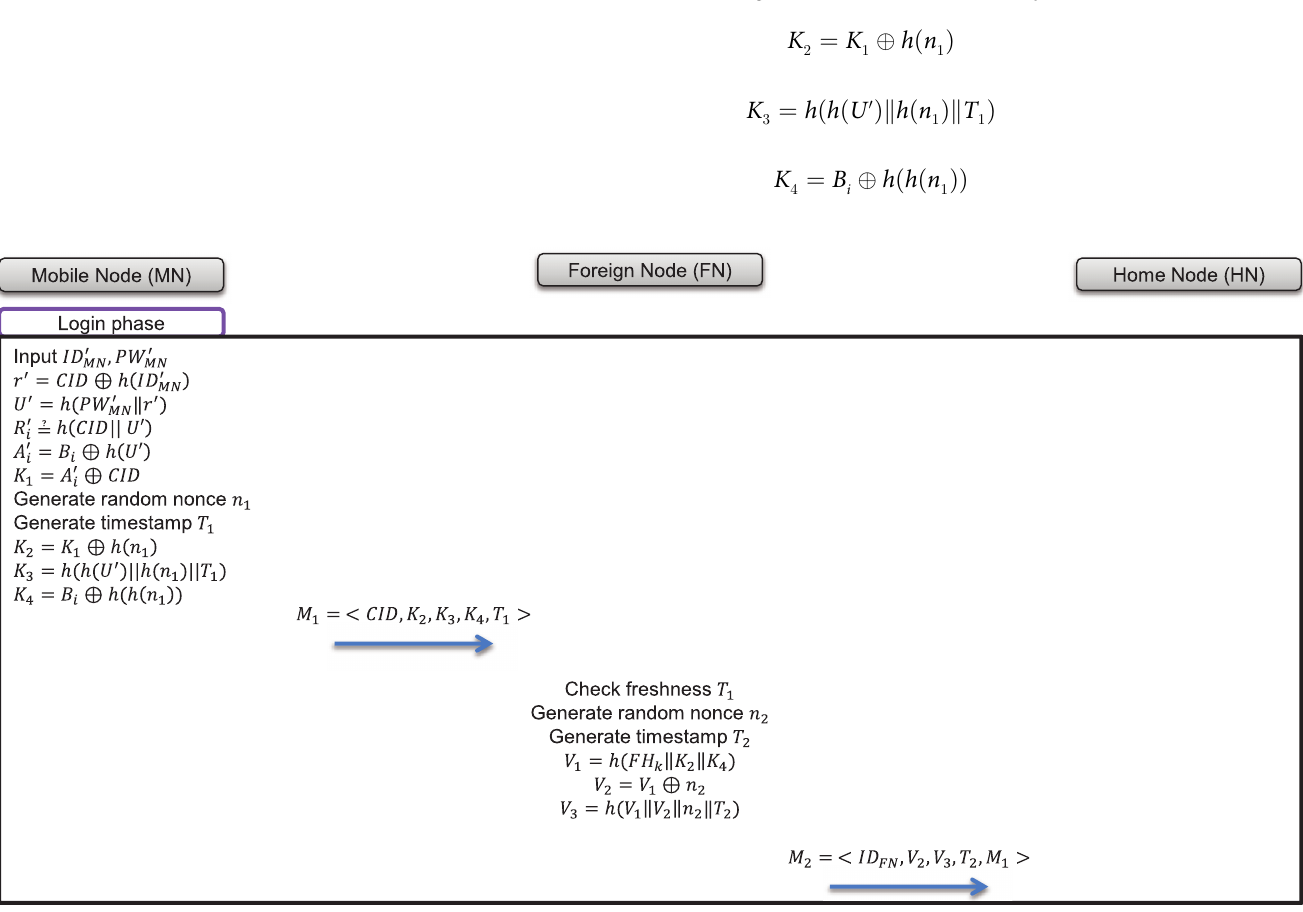
Fig 7. Login phase of proposed scheme.